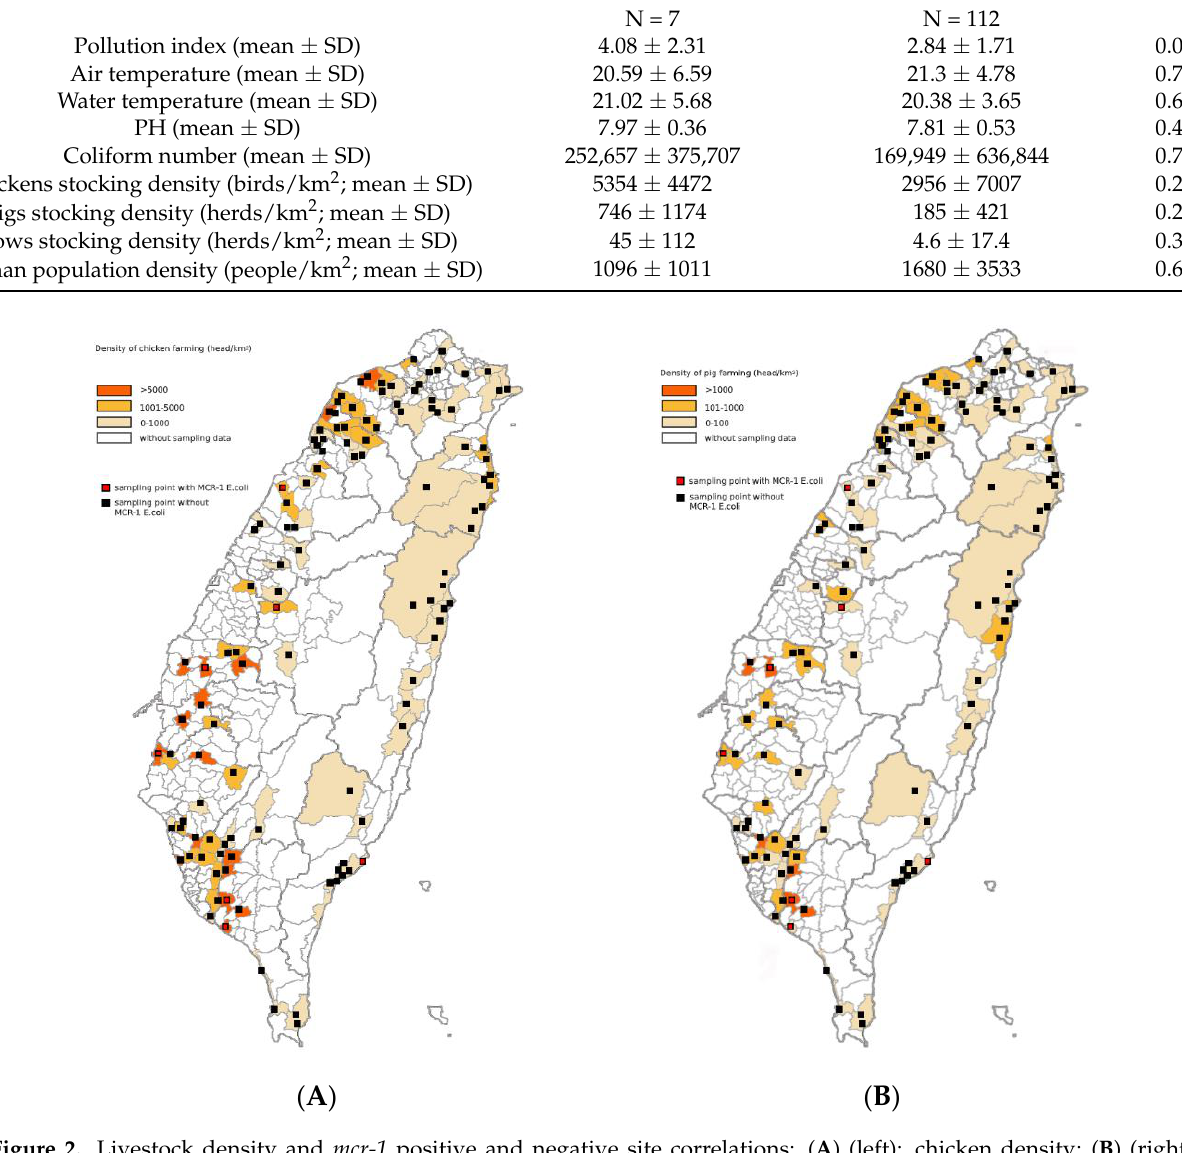
Table 2. Independent t -test of the mcr -1-positive and mcr -1-negative E. coli sites.